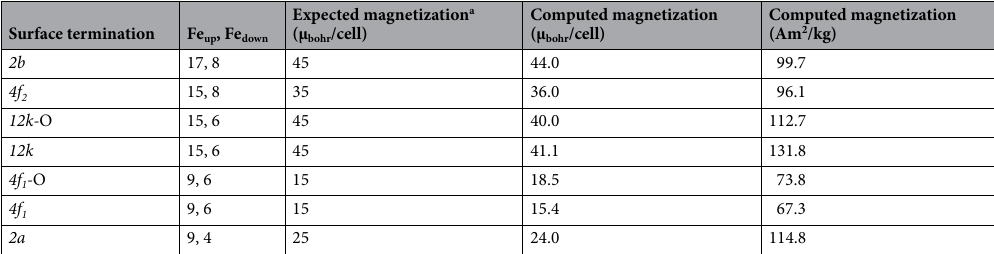
Fig. 8, the net magnetic moment of the slab remains unchanged, regardless of the adsorption mode considered. More concretely, the calculated magnetic moment of a fully hydroxylated 12k-O surface is 42 μ bohr /cell, remaining invariant for the two adsorption modes. According to our calculations, we can conclude that the experimentally observed changes in the Ms values for the BSHF coated with EDTMP at 80 °C do not stem from the adsorption of the ligand. This agrees with the observed negligible effect of the coatings on the average Fe local structure (Fig. S2 and Tables S1, S3 and S4). An alternative explanation to the observed change in magnetic moments due to the adsorbed EDTMP ligand is the degradation of the BHSF NPLs, resulting in the dissolution of the surface crystal planes (as in Fig. 4b) or even an entire S block (as shown previously in 12 ). In order to shed light on the matter, the thickness and surface morphology of the BHF NPLs were considered as potential causes for the observed changes. We cut slabs of different thicknesses from the BHF bulk (Fig. 7b) and calculated the net magnetization for each considered ter- mination. Our results (Table 2) indicate a strong dependence of the magnetic moment of the slab on the specific bulk termination. The change in magnetization can be solely attributed to the number of Fe 3+ ions in each of the antiferromagnetically aligned sublattices (Fe up and Fe down in Table 2), as evident by the expected versus computed magnetization values. For instance, the 4f2 terminated surface loses two Fe up with respect to the 2b termination, resulting in a magnetization decrease of 8 μ bohr /cell. From first-principles modelling, we conclude that the loss of magnetic moment in the case of the adsorption of EDTMP is not due to the adsorption of the ligand; instead, it is a consequence of the observed NPLs disintegration.